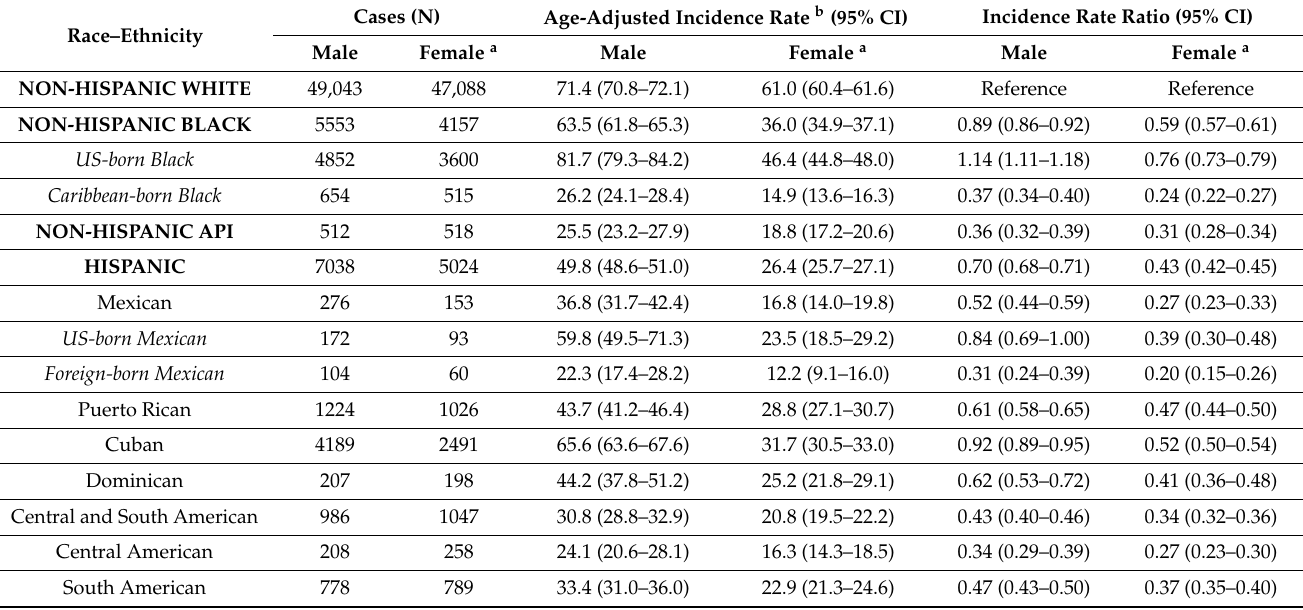
Table 3. Age-Adjusted Incidence Rates and Incidence Rate Ratios of Lung Cancer by Detailed Race–Ethnicity and Sex. Florida,